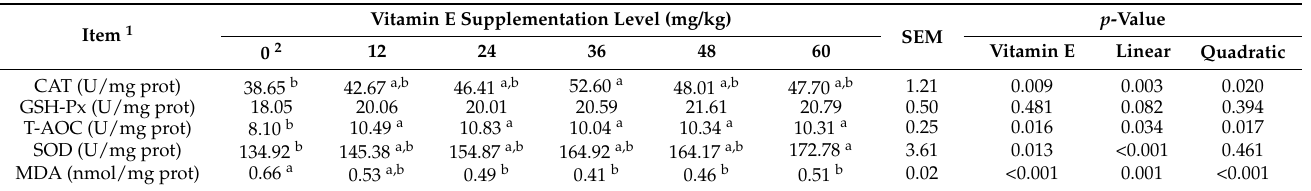
Table 7. Effect of dietary vitamin E supplementation on the antioxidant capacity in the liver of male Jiangnan white goslings on day